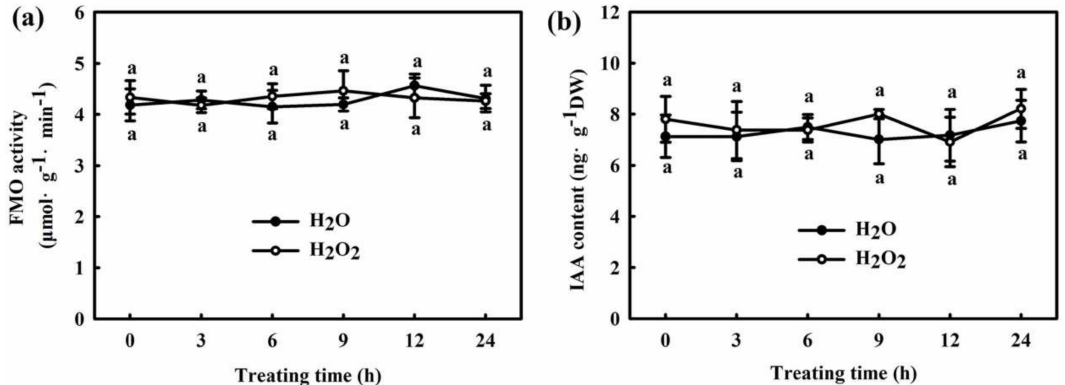
Figure 7. Effects of H 2 O 2 on the FMO activity ( a ) and IAA content ( b ) in cucumber seedlings. Cucumber seedlings were foliar sprayed with 1.0 mM H 2 O 2 or deionized water (control), and then, we measured the changes of FMO activity and IAA content within 24 h. The data represent the mean ± SD of three biological replicates. Different letters indicate significant differences ( p < 0.05), according to Duncan’s new multiple range